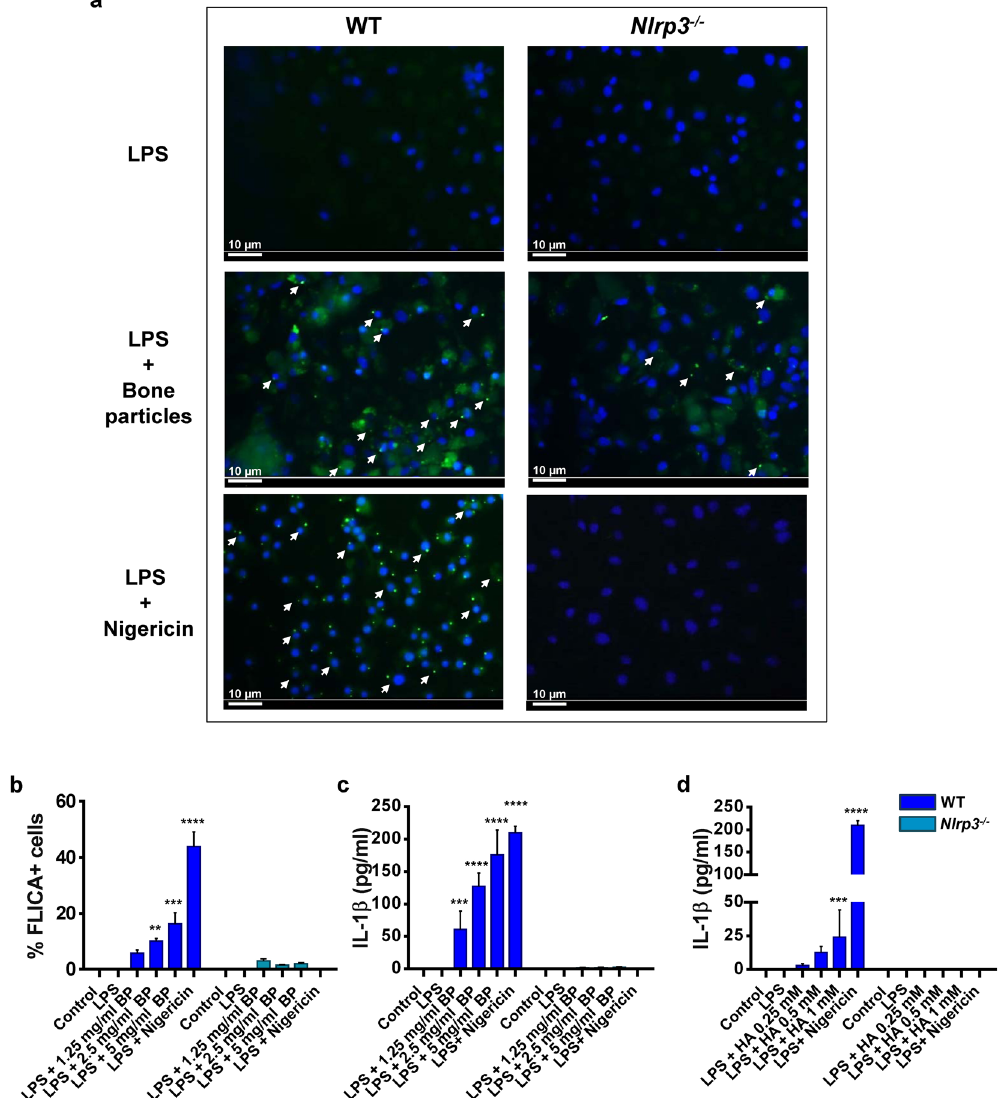
Figure 2. Bone matrix components provide secondary signals that assemble functional inflammasomes. WT or Nlrp3 − / − BMM were incubated for 3 hours with 100 ng/ml LPS and stimulated with 15 µ M nigericin for 30 minutes, bone particles (BP, 1.25–5 mg/ml) or hydroxyapatite (HA) crystals (0.25–1 mM) for 1 hour. ( a ) Cells were then incubated with FLICA TM FAM-YVAD-FMK probe and analyzed by fluorescence microscopy. Original magnification, 20x; scale bars = 10 µ m; white arrows show foci of caspase-1 activation. ( b ) Quantification of FLICA + cells. Data are means ± SD of at least 3 fields. ( c , d ) IL-1 β release in the conditioned media. Data are means ± SD from experimental triplicates, and are representative of at least 2 independent experiments. ( b ) ** p = 0.0062, *** p = 0.0003, **** p < 0.0001; ( c ) *** p = 0.0008, **** p < 0.0001. p values correspond to significant differences relative to the control for each